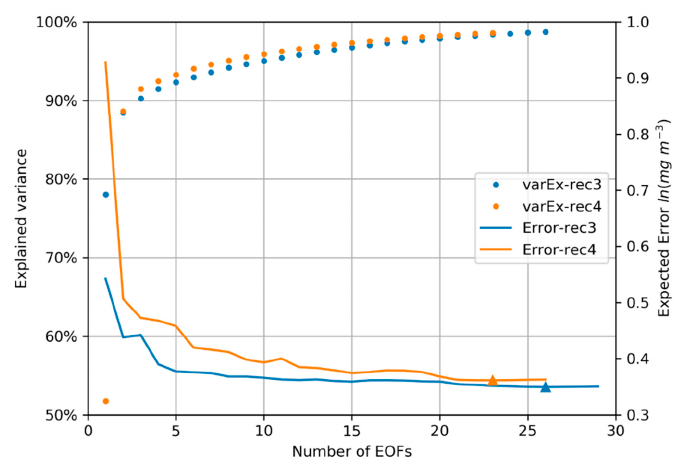
Figure 6. Cross-validation root mean square error (RMSE) (solid lines) and cumulative explained variance (solid circles) for the DINEOF reconstructions. The minimum error is marked with a triangle on each line.